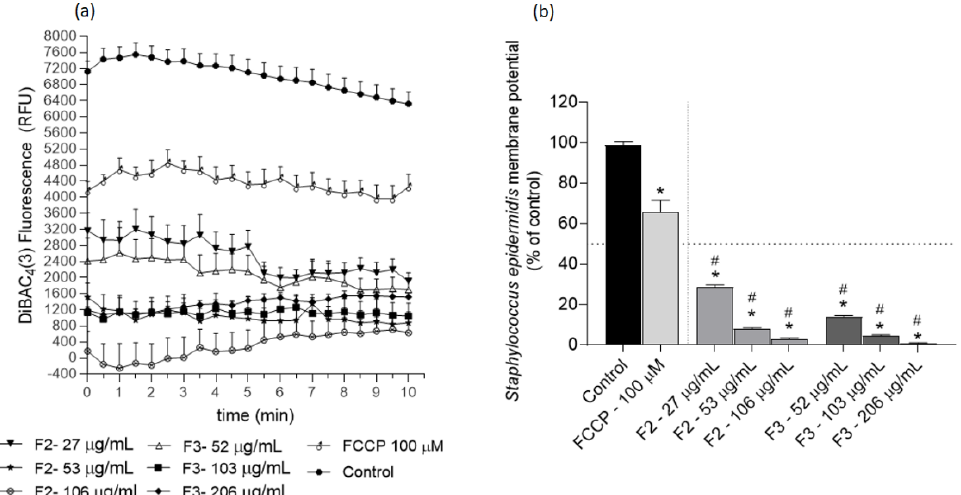
Figure 4. Staphylococcus epidermidis membrane potential when exposed to Gelidium corneum F2 (water insoluble) and F3 (diethyl ether) fractions at ½ IC 50 ; IC 50 and 2 × IC 50 , labelled with DiBAC 4 (3) probe; ( a ) 30 s interval readings; ( b ) after 10 min. FCCP (100 μ M) was used as positive control and DMSO as negative control. Each value and bars represent the average of three independent experiments. Vertical lines represent the standard error of the mean (SEM). Symbol (*) represents significant differences when compared to the control. Symbol ( # ) represents significant differences when compared to FCCP (ANOVA, Dunnett’s test, p < 0.05).